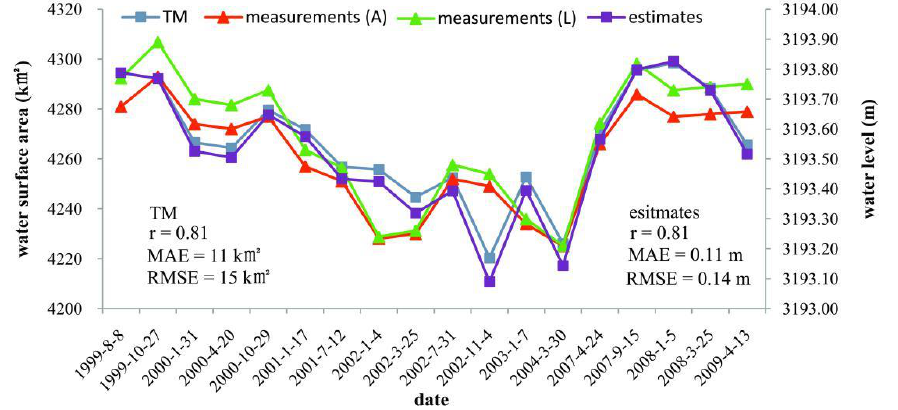
Figure 4. Time series of surface areas extracted from Landsat TM images versus measurements and the extended water levels estimated by the L-A equation established in Section 4.3 and the surface areas extracted from Landsat TM images as inputs. The blue square represents the surface areas estimated from Landsat TM images, and the red triangle represents the surface areas observed at Xiashe station, which was retrieved from the water level observations and the L-A curve provided by the Hydrology and Water Resources Survey Bureau of Qinghai Province. The purple square represents the extended water levels that were estimated by using the L-A equation in Section 4.3 and the surface areas extracted from Landsat TM images as inputs, while the green triangle represents the water levels measured at the Xiashe